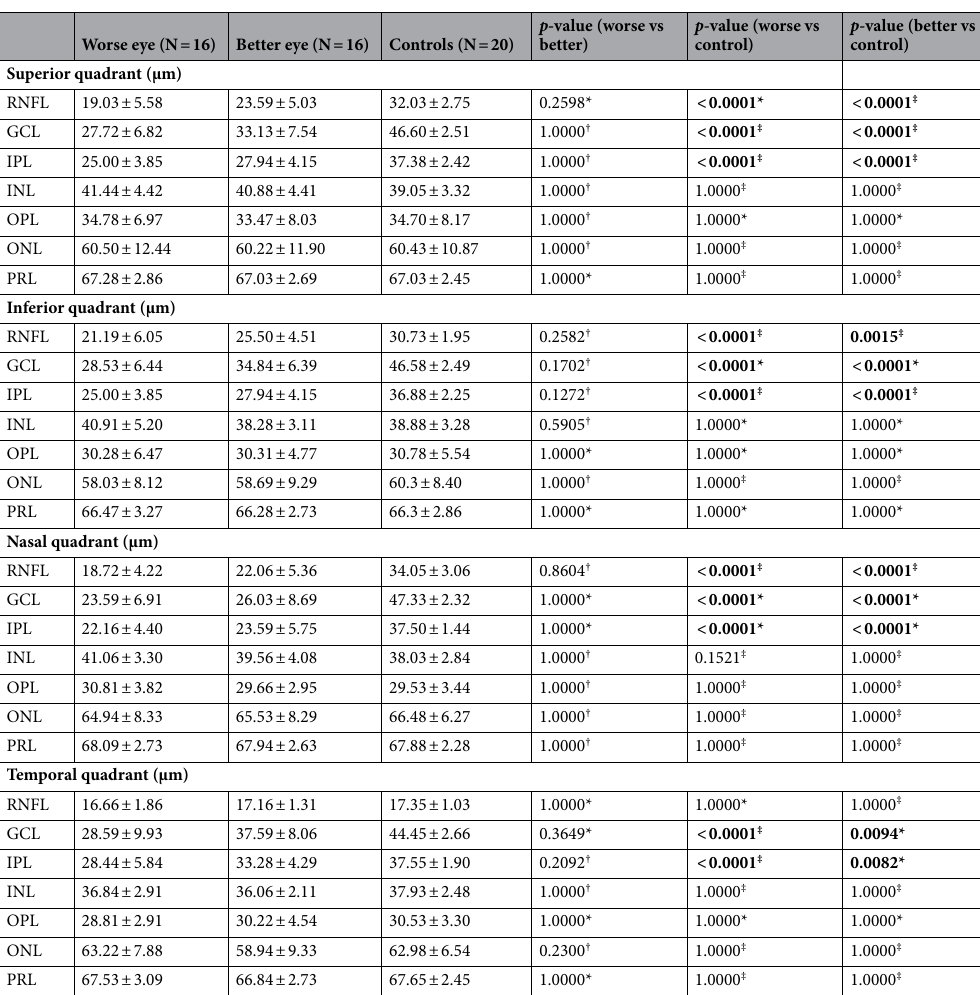
retinal nerve fiber layer, GCL ganglion cell layer ganglion cell layer, IPL inner plexiform layer, INL inner nuclear layer, OPL outer plexiform layer, ONL outer nuclear layer, PRL photoreceptor layer. * P -values